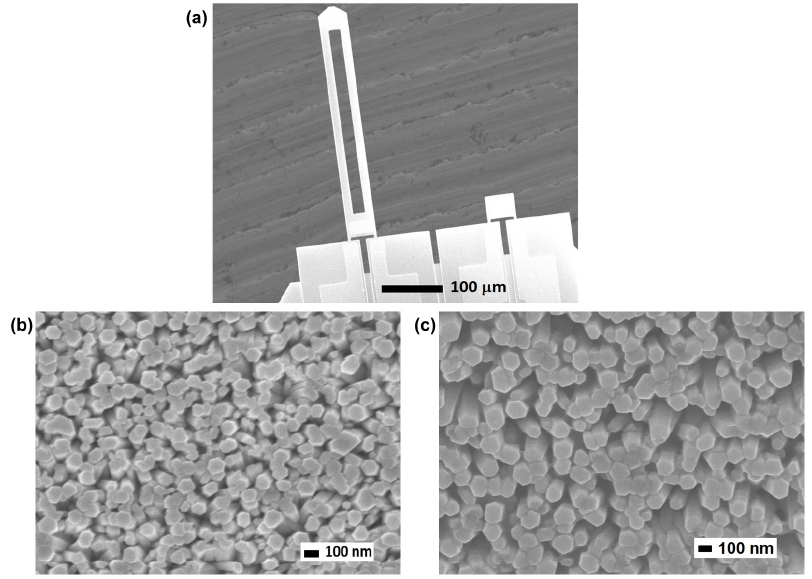
Figure 3. ( a ) Field emission-scanning electron micrograph of the microcantilever and magnified images of ZnO nanorods on the MC surface for ( b ) upper surface and ( c ) lower surface taken by JEOL JSM-7600F, Japan at an accelerating voltage of 5 kV. A vertical nanorod structure and hexagonal shape with diameter of around 100 nm were observed.